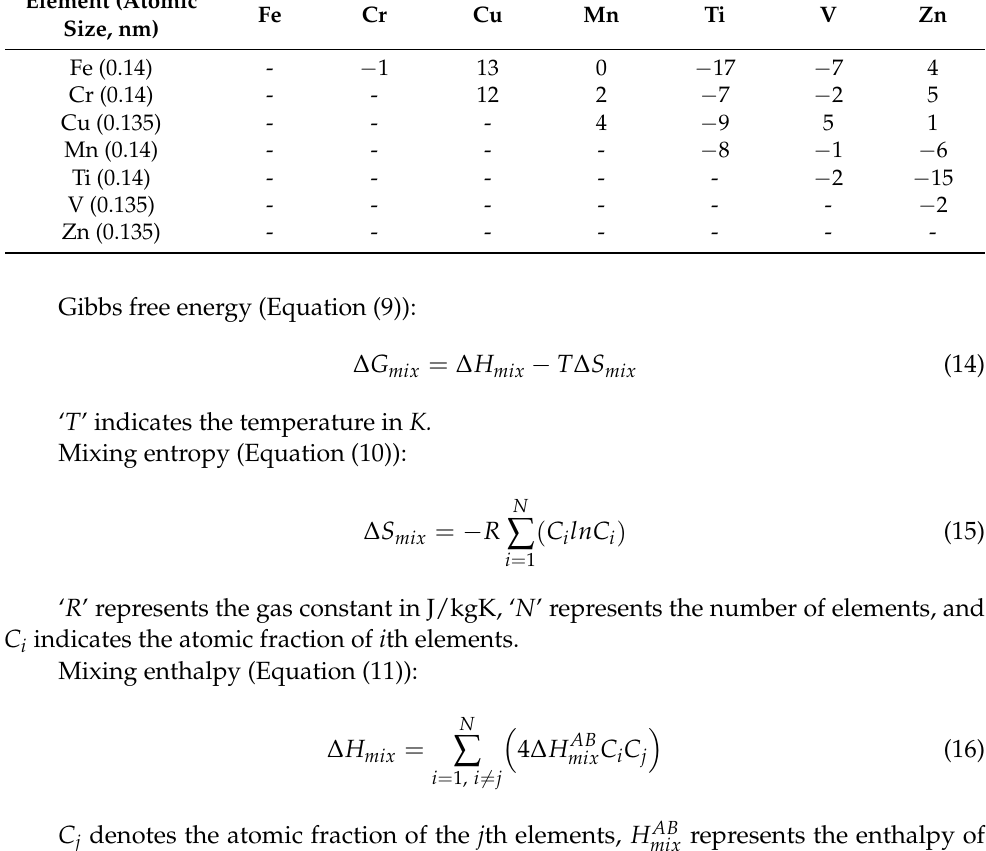
, kJ/mol) of three developed equiatomic high entropy ij